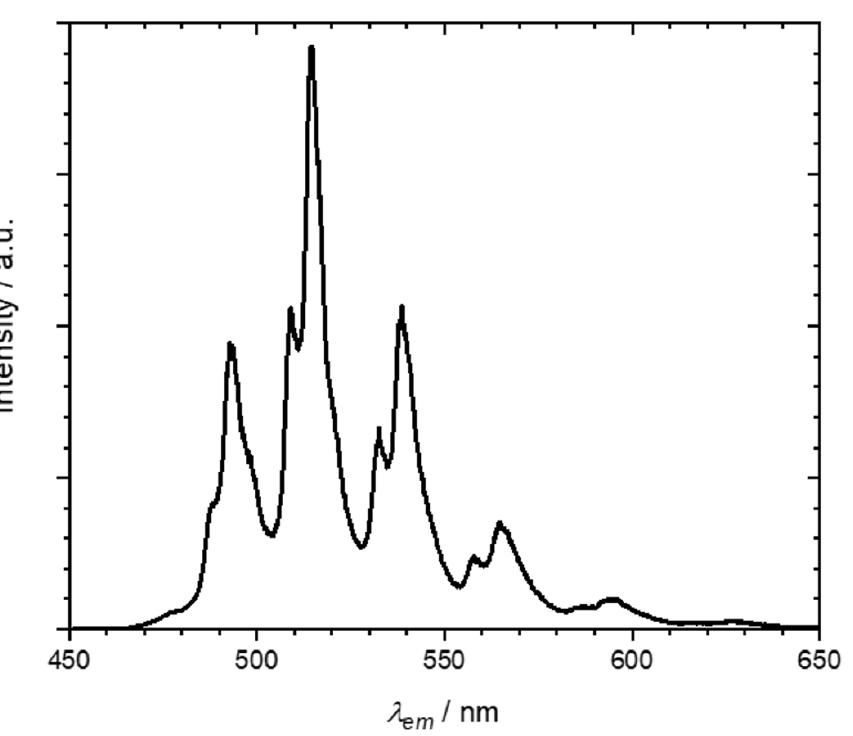
Figure 6. Raw luminescence emission spectrum for uranyl sulphate powder (UO 2 SO 4 · 3.5H 2 O) with λ ex held at 266.0 nm. Intensity is given in arbitrary units (a.u.).